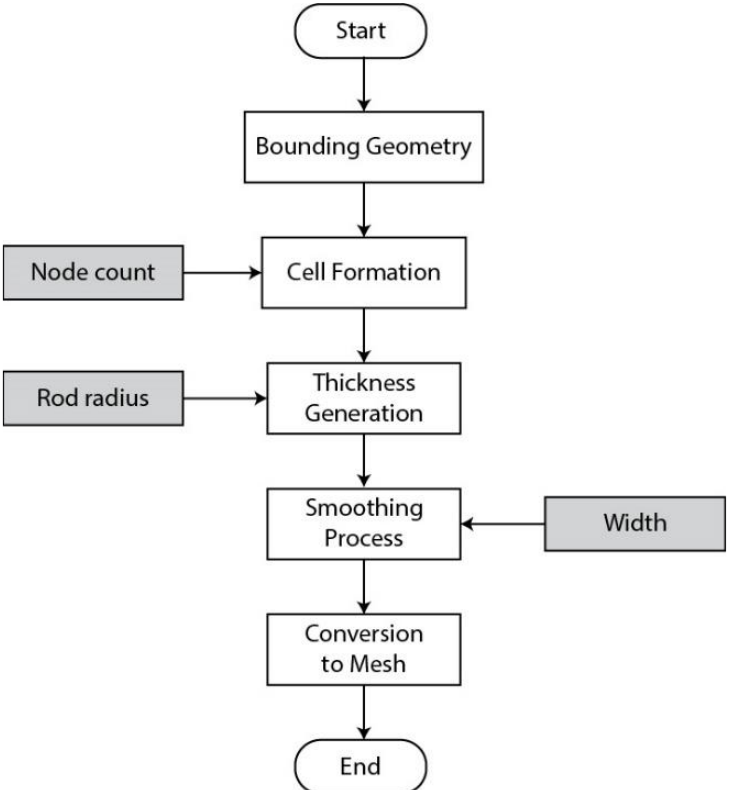
Figure 6. Top-level workflow diagram of the interactive, parametric design process of a biomimetic Voronoi lattice. The most important user-defined parameters are found in the grey boxes.